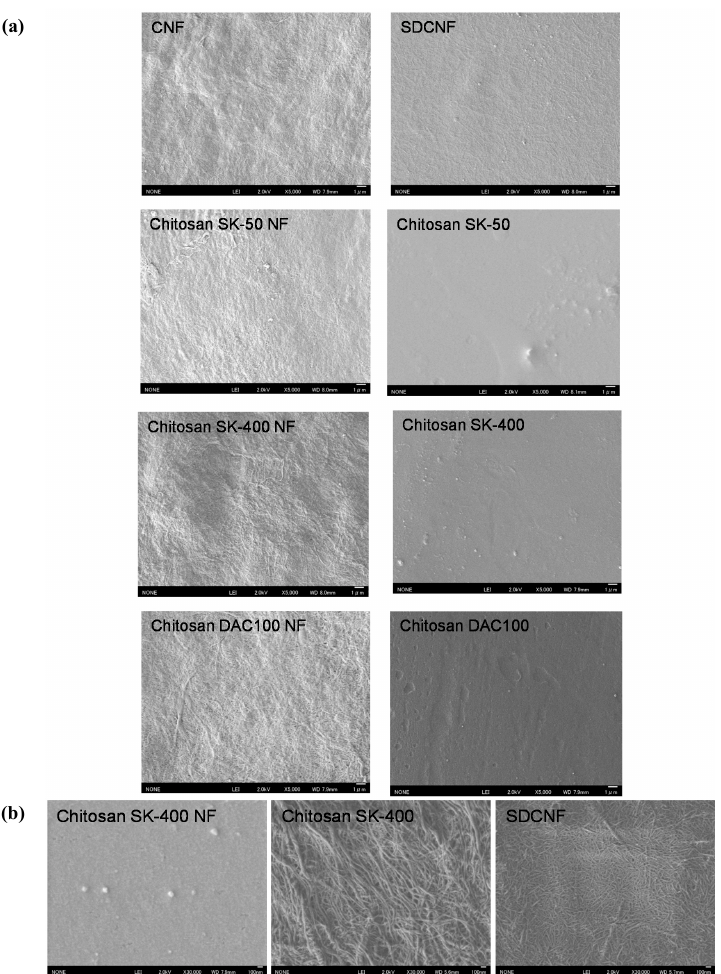
Figure 1. Field emission scanning electron microscopic (FE-SEM) micrographs of sheets. ( a ) SEM micrographs of chitin nanofiber (CNF), surface-deacetylated chitin nanofiber